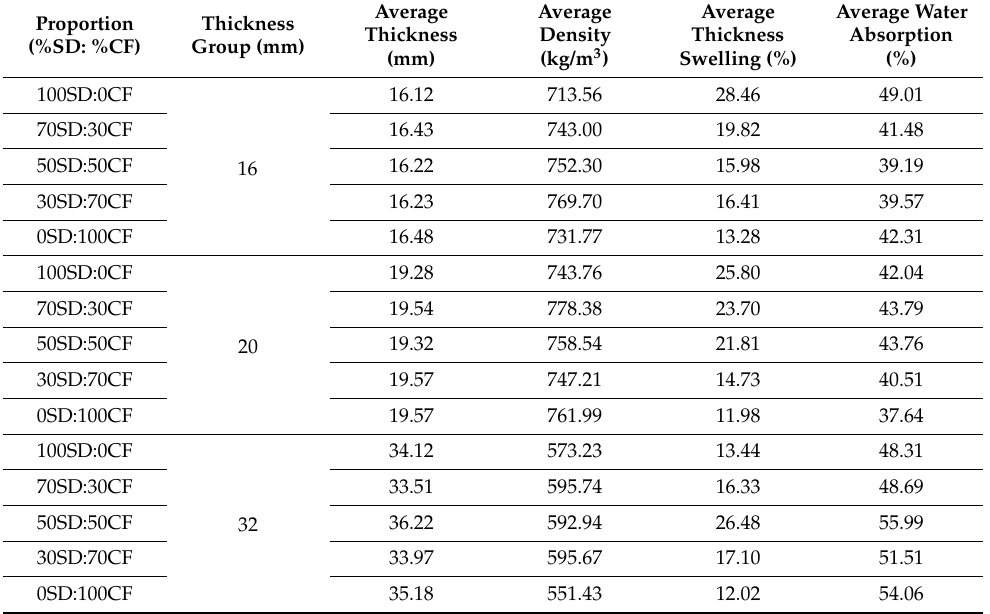
Table 5. Summary on Density, Thickness Swelling and Water Absorption of Test Pieces of All